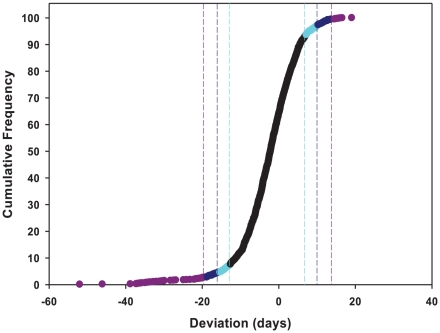
Cumulative frequency distribution of effects of mutations on life span.Life spans are averaged across sexes, and expressed as deviations from the mean of co–isogenic controls. Lines with mean life spans exceeding the 95%, 99% and 99.9% confidence intervals are depicted in cyan, dark blue and dark pink, respectively.